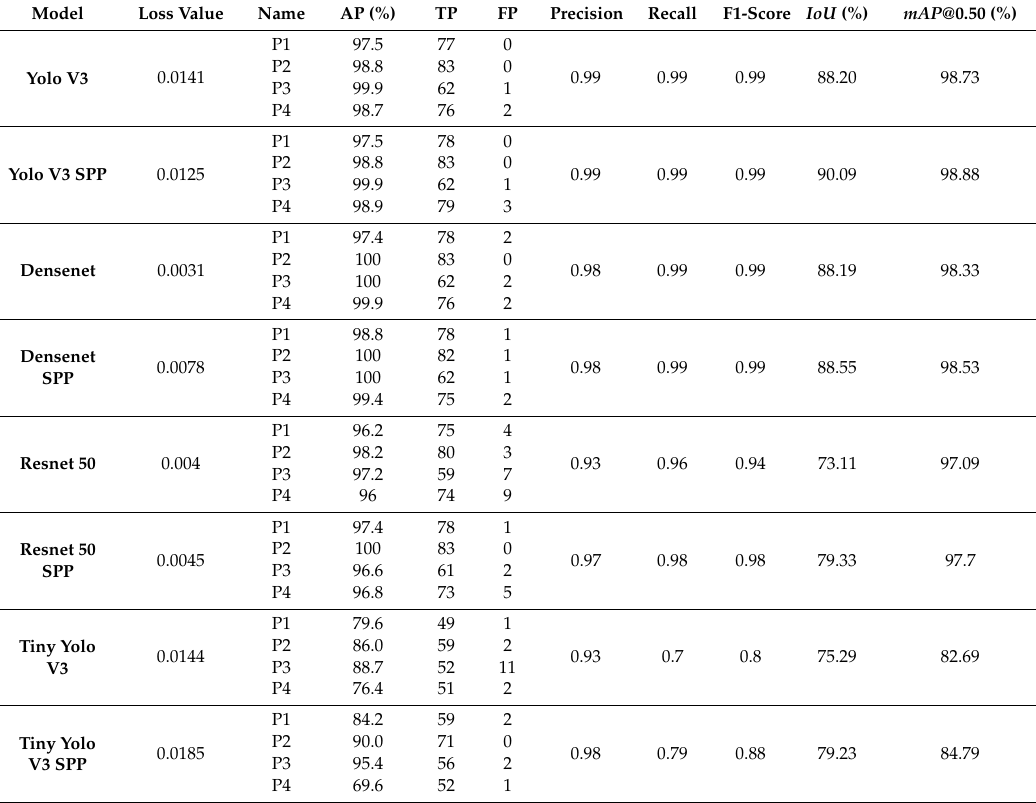
Table 2. Training loss value, mAP, and AP performance for class P1, P2, P3, and